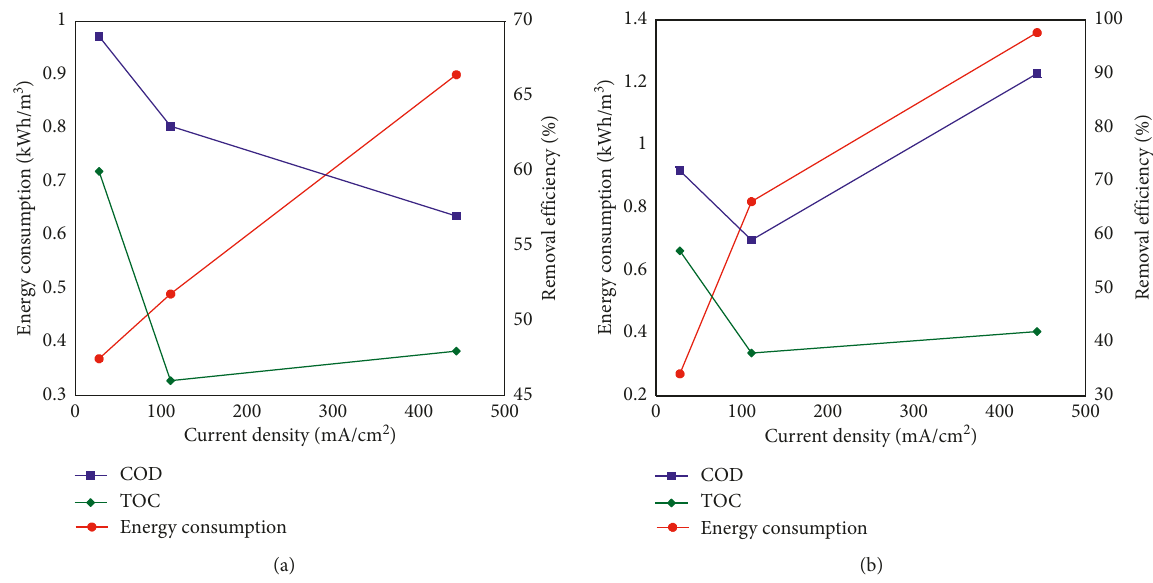
Figure 3: Effect of current density on the energy consumption and the COD and TOC removal efficiencies with (a) Fe electrode and (b) Al electrode. Conditions: pH 7.0; S1-beamhouse wastewater; electrolysis time �